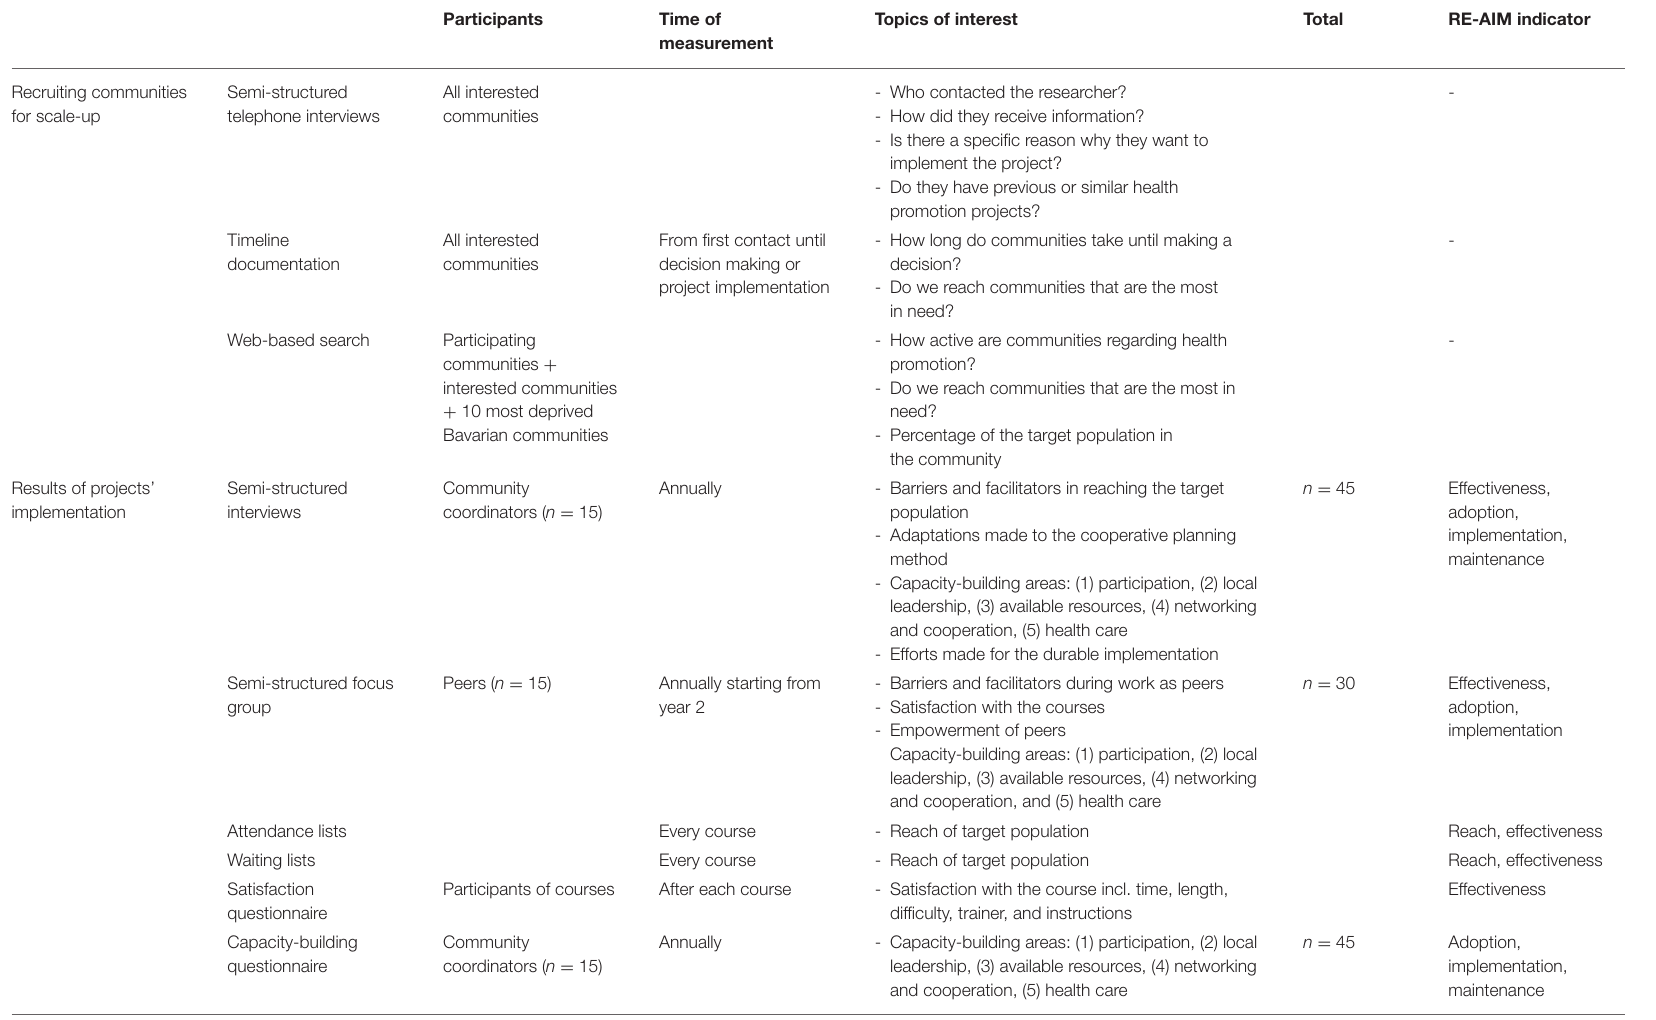
TABLE 3 | Evaluation